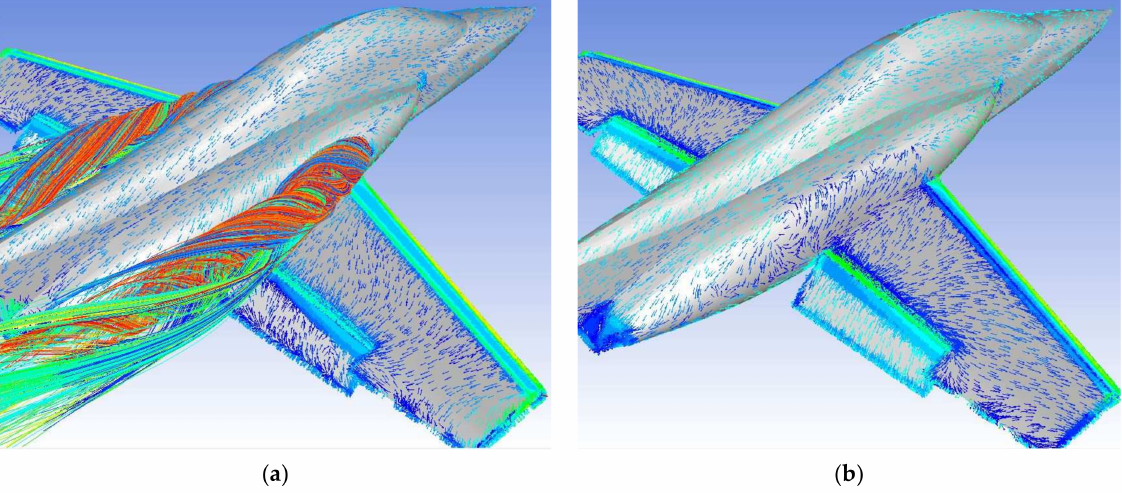
Figure 18. Vectors in the HLF and SSTF configurations of the wing-body in V = 60 m/s at α = 25 ◦ : ( a ) in the presence of PVG and its path lines; ( b ) in the absence of